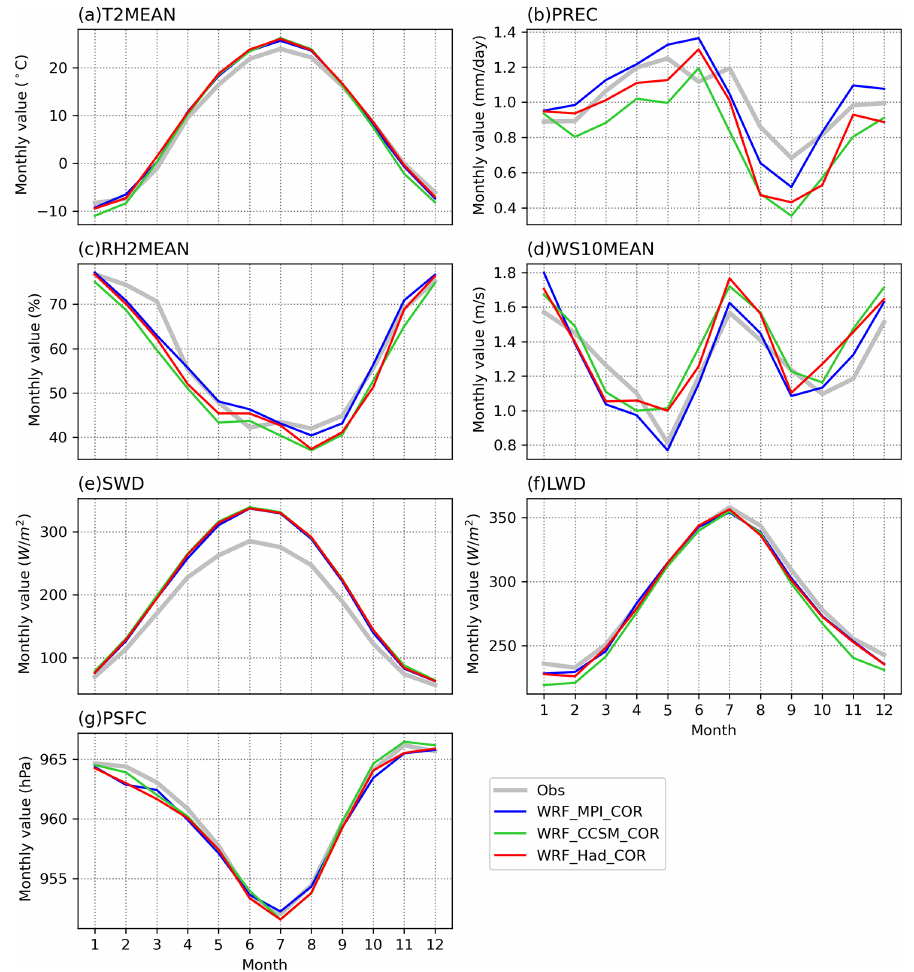
Figure 6. Mean annual cycle of the monthly values averaged over central Asia in the observations and RCM